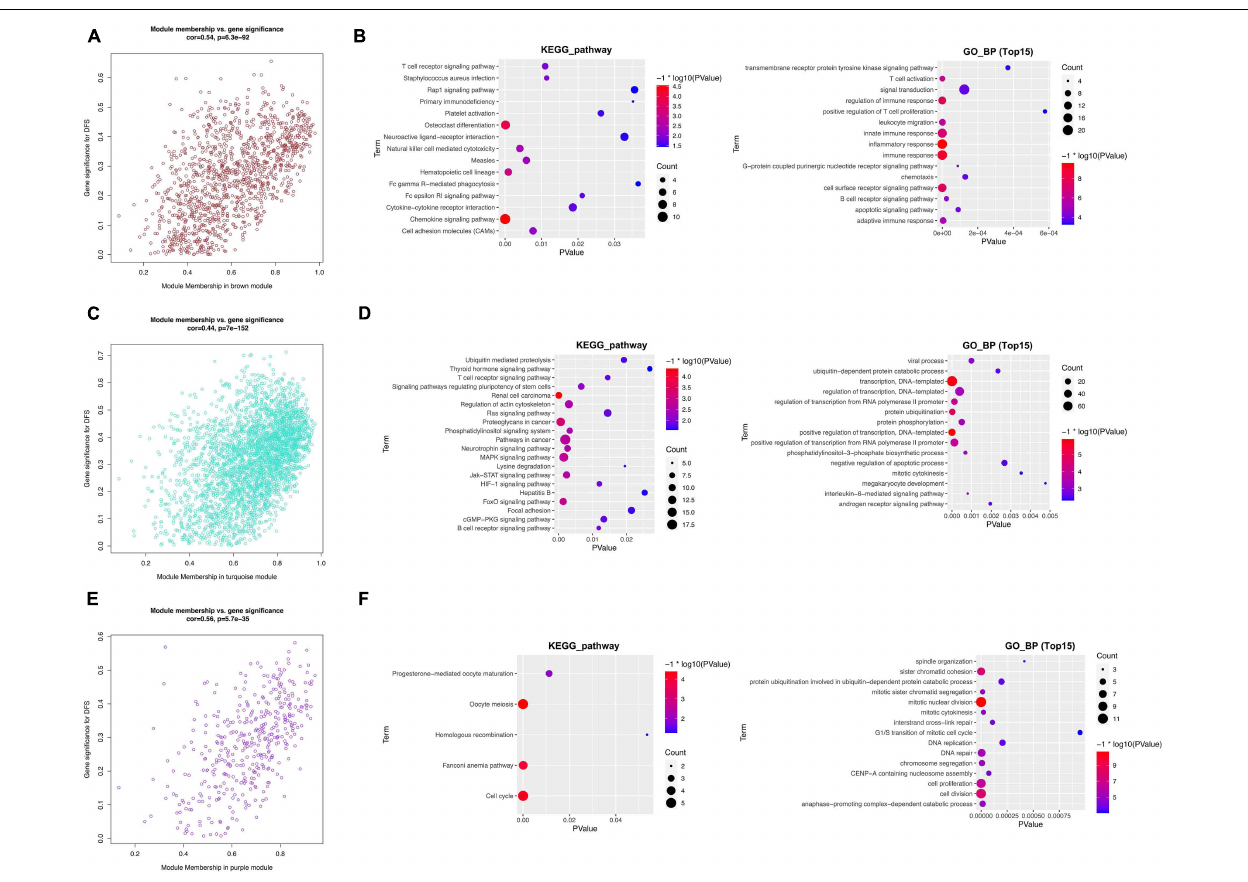
FIGURE 6 | Functional analysis of key module genes. (A,B) Brown module and KEGG pathway and GO_BP analysis of key module genes. (C,D) Turquoise module and KEGG pathway and GO_BP analysis of key module genes. (E,F) Purple module and KEGG pathway and GO_BP analysis of key module